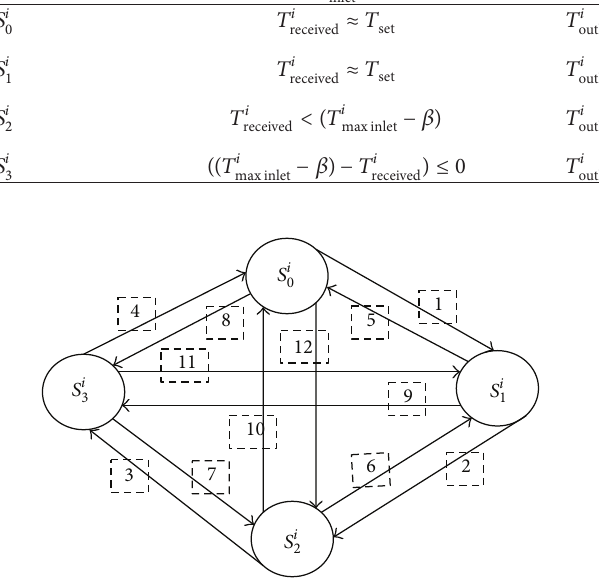
Figure 1: State transition diagram for data center